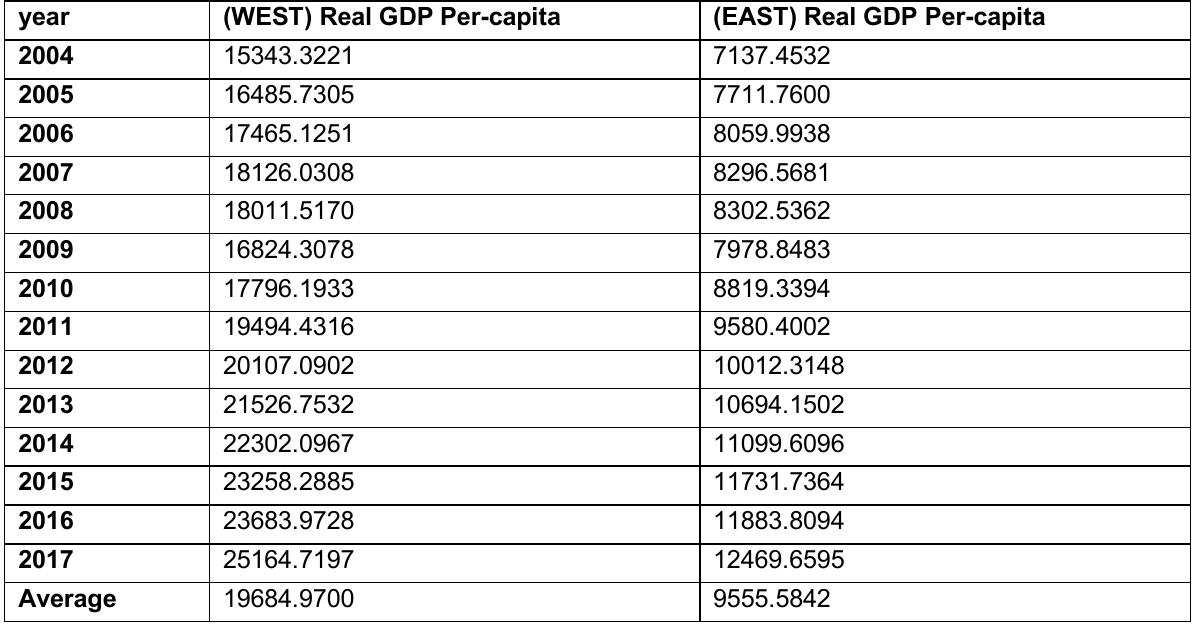
Table 9: West-East Real GDP